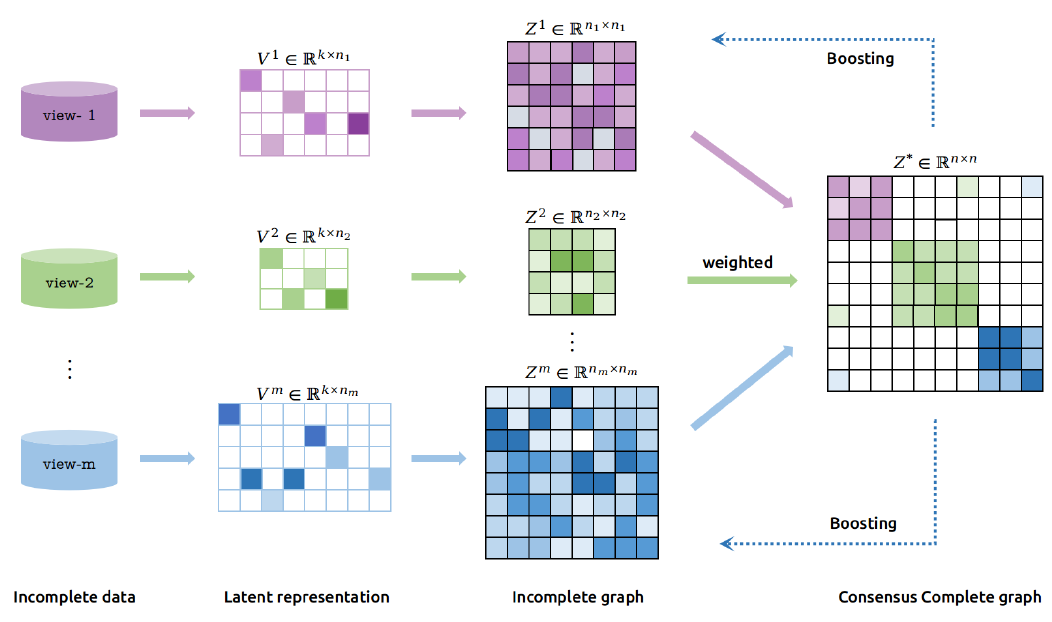
Figure 1. Framework of the proposed adaptive weighted graph fusion incomplete multi-view subspace clustering (AWGF-IMSC). It is a novel incomplete multi-view clustering method to fuse the local-structure contained graph with adaptive view-importance learning. Incomplete graphs of different scales are fused into a complete graph with automatically learning weights. In addition, the constructed complete graph will further guide the learning process of incomplete graphs and latent